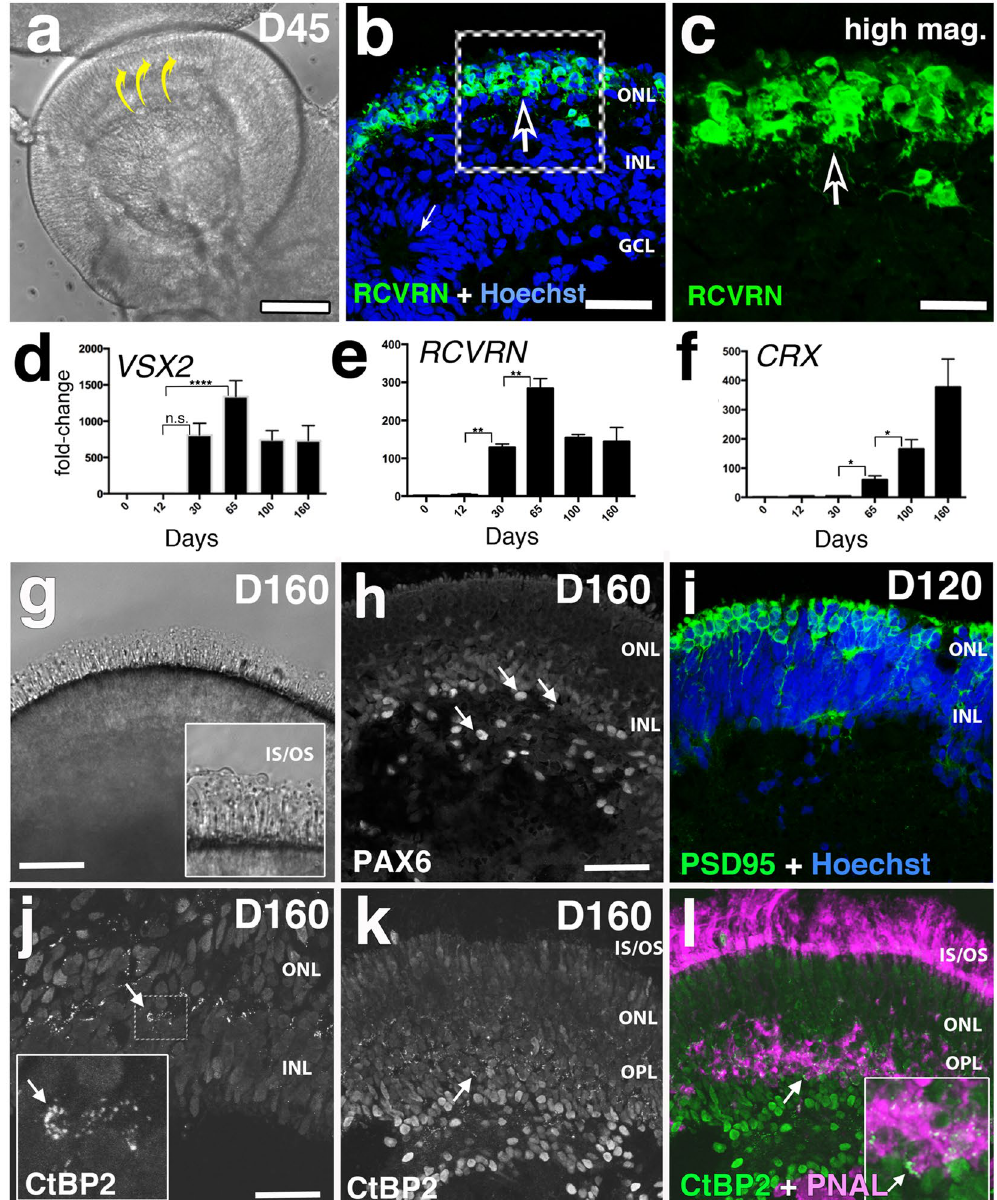
Figure 3. Detection of early photoreceptors after 45 days and markers typical of the neural retina derived from IMR90.4 iPSCs. ( a ) A D45 RC culture with a curved (yellow arrows) pseudostratified appearance. ( b , c ) RCVN ( + ) PRs at D45 line the prospective outer retina. ( d – f ) Quantitative PCR analysis of the early retinal markers VSX2, RCVRN, and CRX was performed on cDNA samples pooled (n = 10) from IMR90.4 iPSCs to confirm their relative levels of expression. ( g ) At D160 OS-like structures were observed protruding from the surface of RCs. A higher magnification image of the POSs illustrates the fine radial architecture (inset box). ( h ) PAX6 immunolabeling at D160 labels neurons in the presumptive INL and GCL (arrows). ( i ) PSD95 immunolabeling at D120 in the outer retina where PRs are located. ( j – l ) CtBP2 staining in nuclei and synapses in D160 retina is highlighted by arciform structures corresponding to ribbon synapses ( j , inset panel). ( j ) The position of CtBP2 labeling at synapses occurs at the base of photoreceptor terminals, a position verified by double labeling with PNAL, a marker for PR inner segments and synaptic terminals ( k , l ; arrow). An inset box in ( l ) corresponds to the region marked by the arrow in panels ( k and l ). Data from pooled samples (n = 10 per time point) was calculated using three replicates per time point and error bars are represented as s.e.m. The difference between the indicated time points is statistically significant by Student’s t-test where **** P < 0.0001, *** P < 0.001, ** P < 0.01, * P < 0.05; ns, not significant. INL = inner nuclear layer; OS-like = outer segment-like; PNAL = peanut lectin agglutinin; POS = photoreceptor outer segment; PR = photoreceptor, RC = retina cup; RGC = retinal ganglion cell. Scale bars ( a ) = 300 μ m, ( b ) = 50 μ m, ( c ) = 25 μ m, ( g ) = 40 μ m, ( h , i , k , l ) = 60 μ m, ( j ) = 50 μ